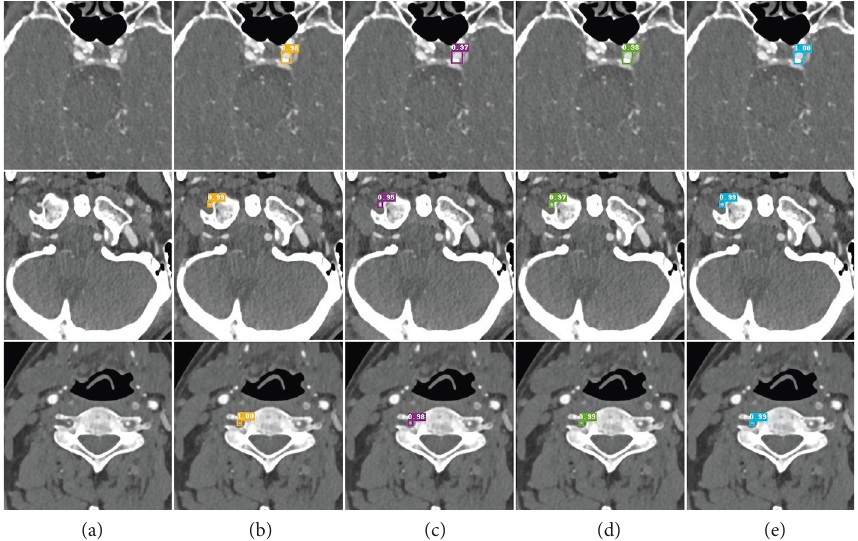
Figure 9: Prediction of retrained Faster R-CNN. (a) Raw image, (b) Faster R-CNN, (c) Faster R-CNN+dcn, (d) Faster R- CNN+dcn +nonlocal, and (e) Faster R-CNN+dcn+nonlocal+cascade